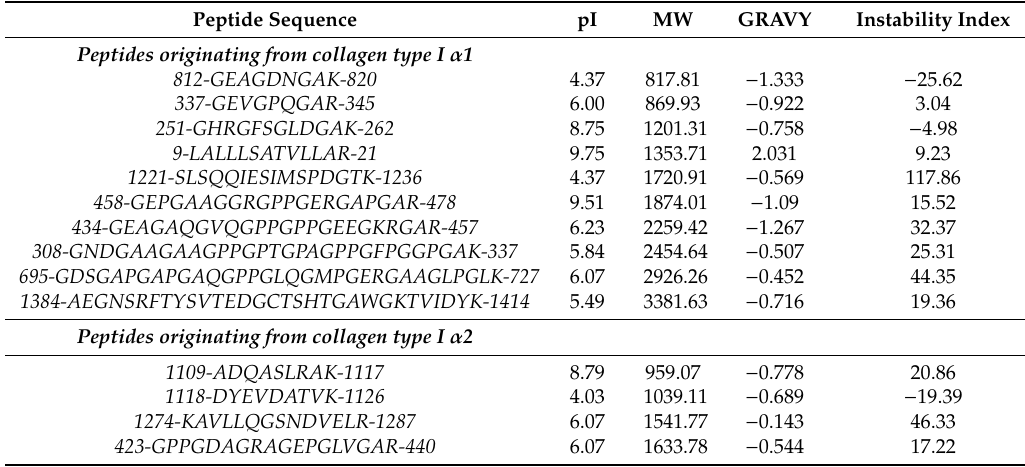
Table 1. Physicochemical properties of the peptides obtained through papain-assisted hydrolysis of